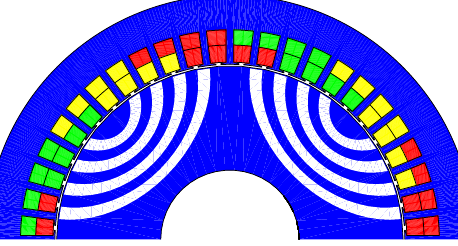
Figure 26. p = 2, Q s = 48, τ a = 2 SynRM geometry.